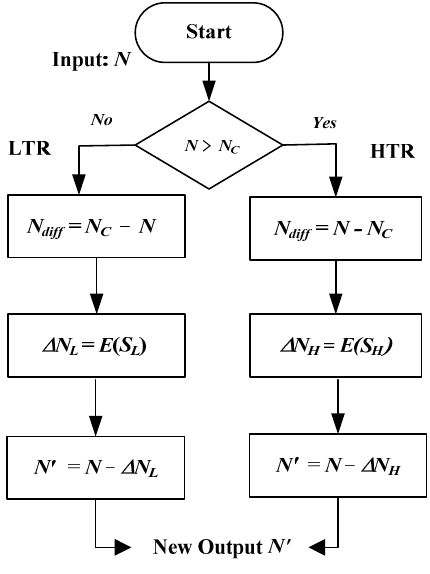
Figure 8. Flowchart for the linearization procedure.